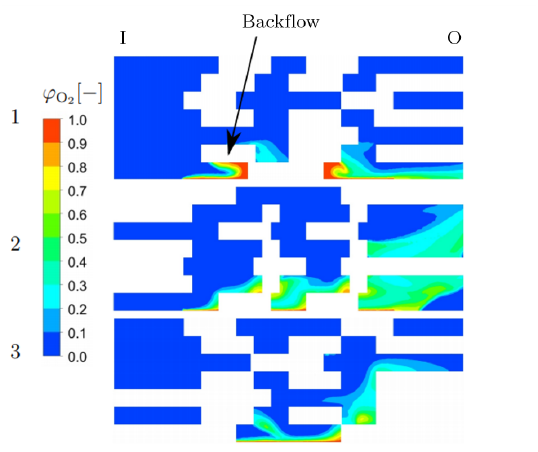
Figure 12. Distribution of ( a ) velocity of H 2 O and ( b ) velocity of O 2 of the Eulerian multiphase model.